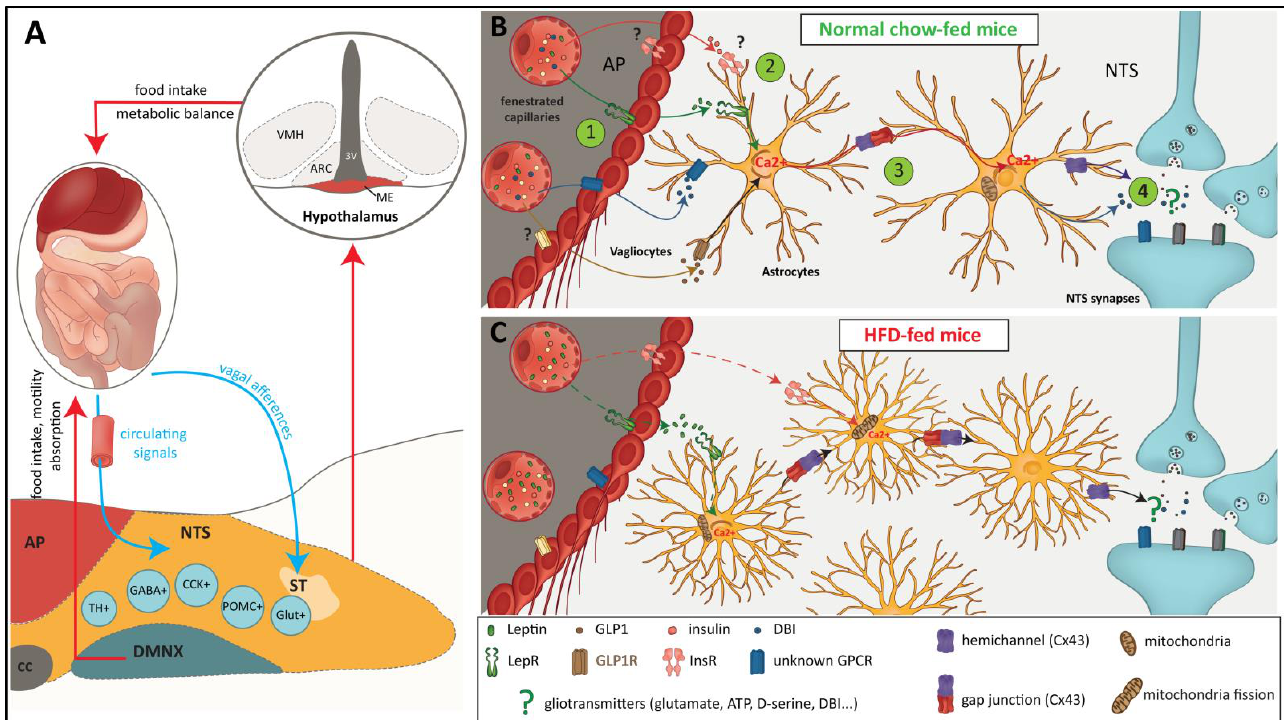
Figure 4. ( A ): Simplified representation of the role of DVC in the regulation of food intake, gastrointestinal functions, and energy balance. Different neuronal populations of the NTS/AP integrate peripheral metabolic signals conveyed by both the vagus nerve and the blood (blue arrows). Then, efferent signals are sent to the hypothalamus and the gastrointestinal tract to regulate metabolic balance (red arrows). CCK: cholecystokinin, GABA: gamma-aminobutyric acid, Glut: glutamate POMC: pro-opiomelanocortin, TH: tyrosine hydroxylase. 3V: 3rd ventricle, AP: area postrema, ARC: arcuate nucleus, cc: central canal, DMNX: dorsal motor nucleus of the vagus nerve, POMC: pro-opiomelanocortin, ME: median eminence, NTS: nucleus of solitary tract, ST: solitary tract, VMH: ventromedial hypothalamus. ( B – C ): The role of DVC glial cells in the integration of metabolic signals and the control of food intake is depicted in this diagram. Vagliocytes can help to regulate the diffusion of circulating signals arising from fenestrated capillaries of the AP (bubble 1). NTS astrocytes located in the vicinity of the AP can integrate these metabolic signals (bubble 2). While the diffusion of signaling molecules through astrocytic syncytium is highly probable, thanks to the strong expression of CX43 (bubble 3), the nature of gliotransmitters prone to release by activated astrocytes remains largely unknown (bubble 4). After HFD consumption, the remodeling of glial coverage observed in this area can modify the nature of neuroglia interactions and contribute to the modification of food intake and energy balance.